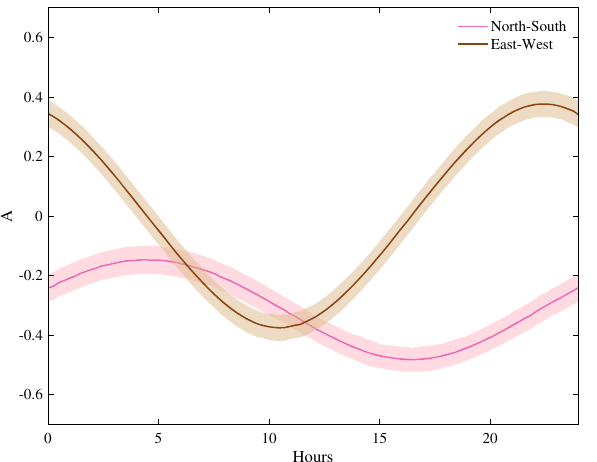
Fig. 2 Theestimated2 σ sensitivityofourexperimentalsetupforatotal target mass of 10 − 3 g. The black line is for an idealized experiment and the red line includes our noise estimates a minimal momentum cutoff, q min = 2 × 10 − 23 kgm/s. We also show the exclusion bounds from CRESST [24,25], EDELWEISS (Migdal) [26] and CDEX (Migdal) [27] as pink, green, light blue and dark red dotted lines, respectively. The blue diamond corresponds to the blue diamond in Fig. 3. For more details, see main